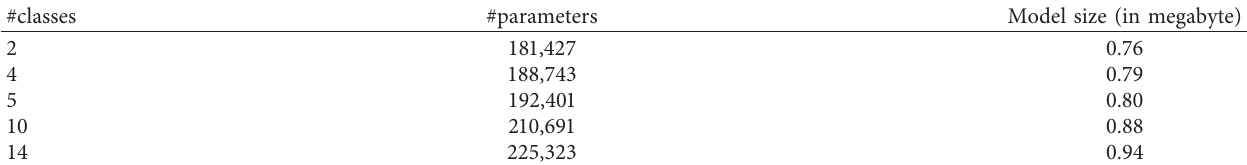
Table 3: Number of parameters and model size of CharTeC-Net based on the number of classes.